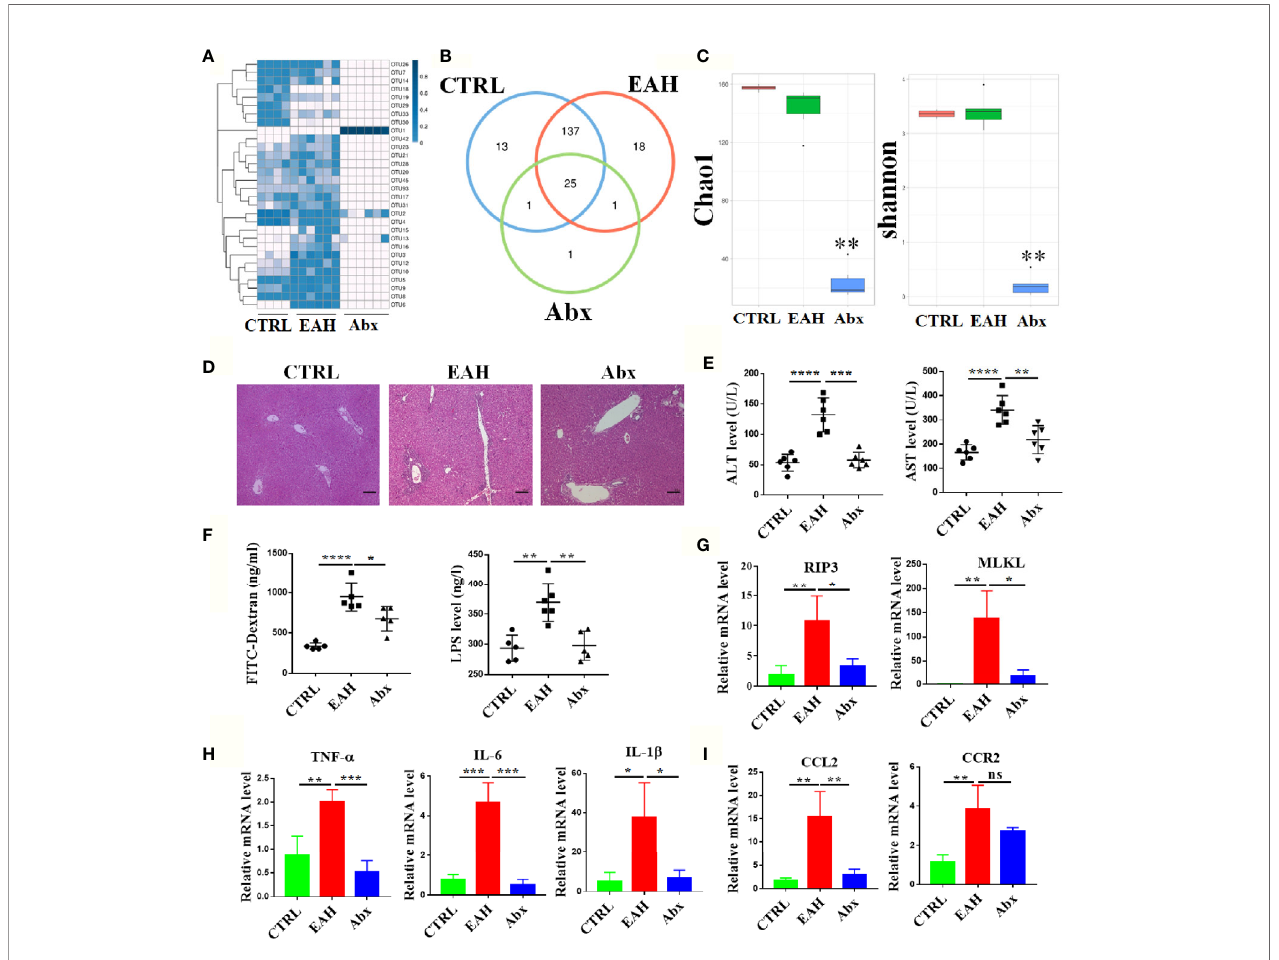
FIGURE 8 | RIP3-mediated activation and in fi ltration of liver macrophages requires gut commensal microbiota. (A, B) Bacterial OUT heatmap (A) and Venn diagrams (B) in the CTRL group (n=4), EAH group (n=6) and Abx group (n=6). (C) The community richness and diversity of the gut microbiota were evaluated with Chao1 and Shannon indexes. (D) HE staining of the liver tissue from three groups. (E) The plasma concentrations of ALT and AST of three groups. (F) The plasma concentrations of FITC-D and LPS of three groups. (G – I) RT-qPCR analysis of RIP3 and MLKL (G) TNF- a , IL-6, and IL-1 b (H) CCL2 and CCR2 (I) in three groups. Scale bars: 100 m m. The data were presented as means ± SD (Student ’ s t-test, *p < 0.05, **p < 0.01, ***p < 0.001, ****p < 0.0001, ns: p >